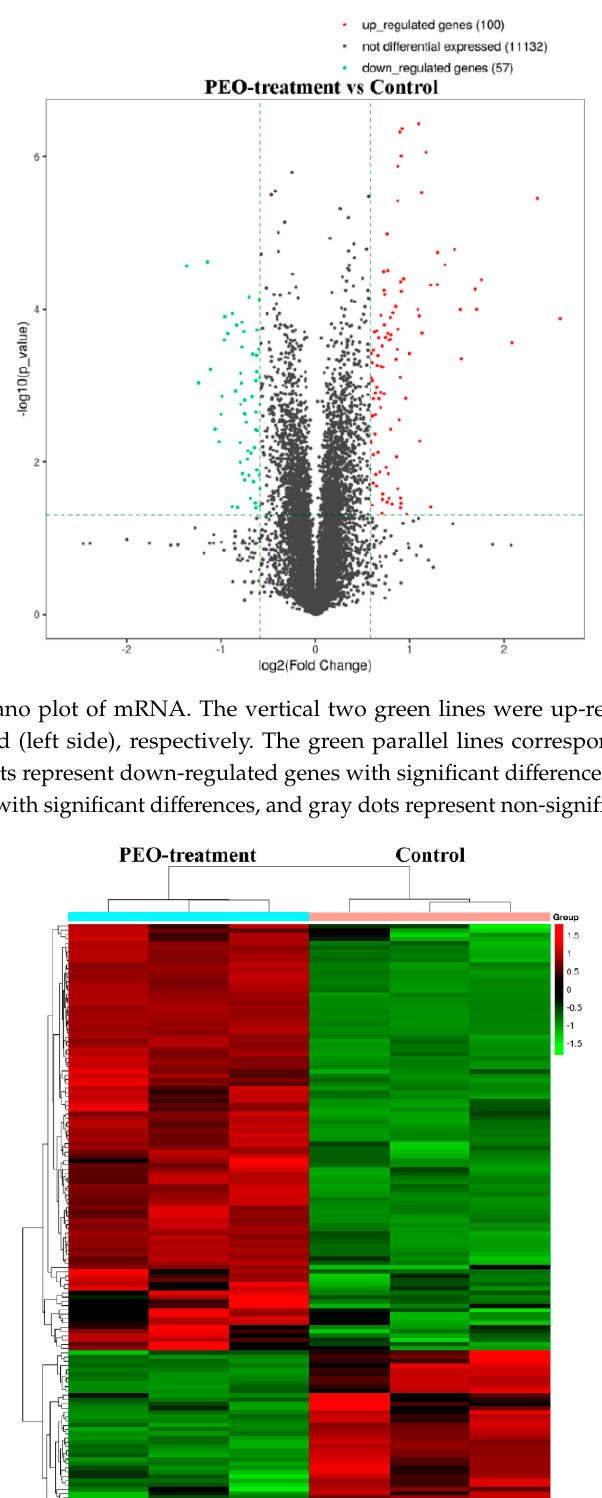
Molecules 2019 , 24 , x; doi: FOR Figure 8. Heat map of DEGs with fold change expression >1.5. MGC-803 cells were treated with 50 µg/mL PEO or control for 24 h ( n = 3). Rows represent genes and columns represent samples. Red blocks represent high and green blocks low expression relative to comparison cells.